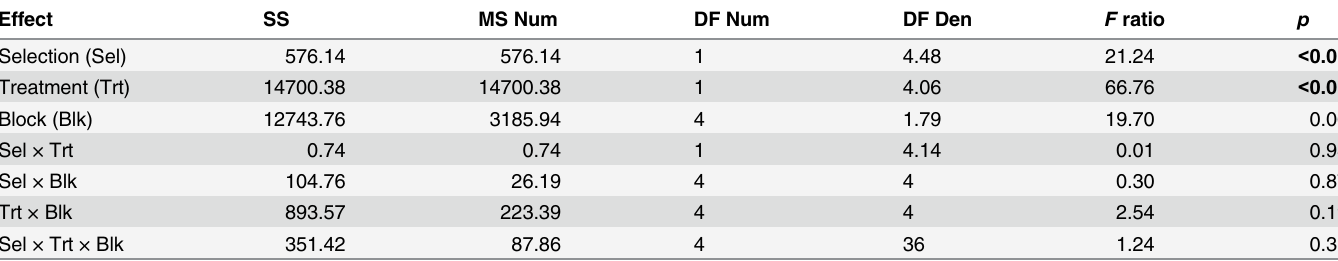
Table 4. Effect of cold shock on number of mating pairs observed (Experiment 1).